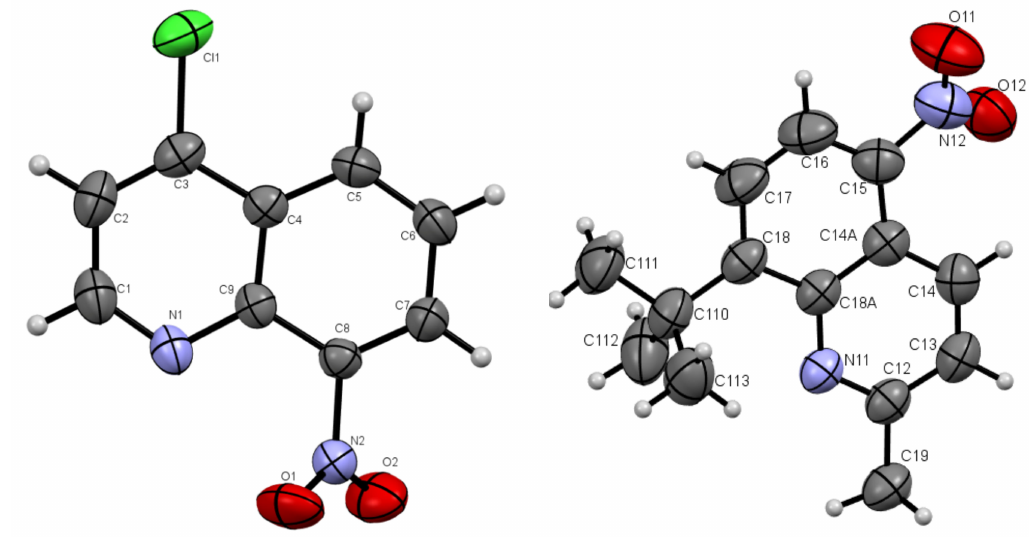
Figure 2. Oak Ridge Thermal Ellipsoid Plot (ORTEP) drawings of compound 4b with 50% probability ( left ). 4c with 50% probability ( right